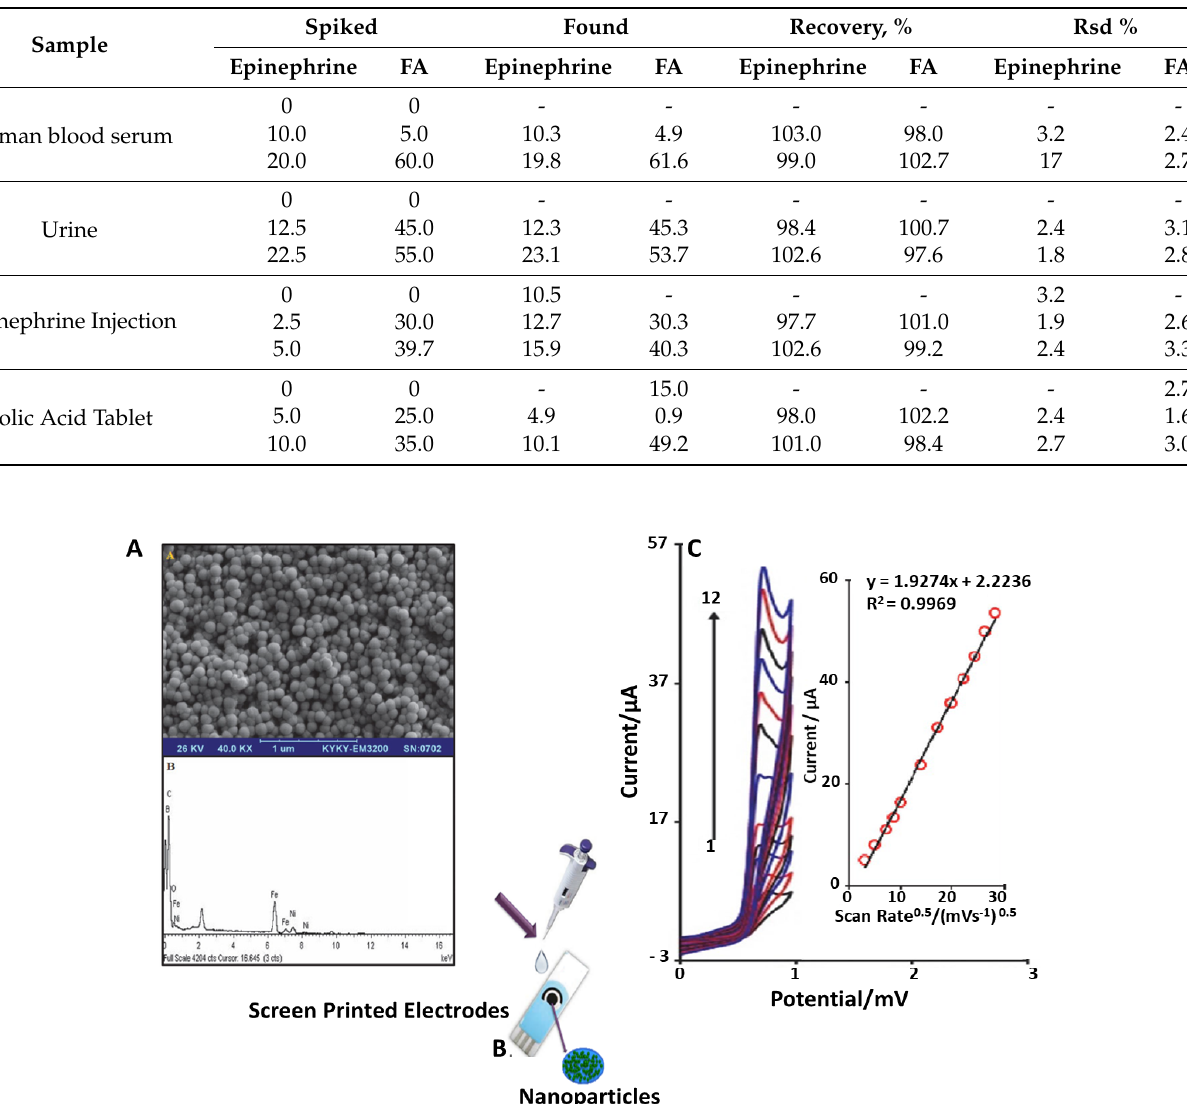
Table 7. Determination of epinephrine and FA in human blood serum, urine, epinephrine injection and folic acid tablet samples. All the concentrations are in µ M (n = 5) [63].